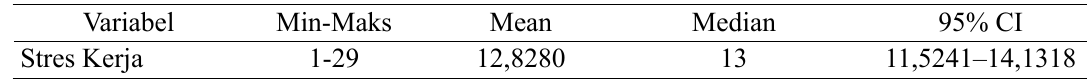
Tabel 1. Deskripsi statistik tingkat stres kerja perawat